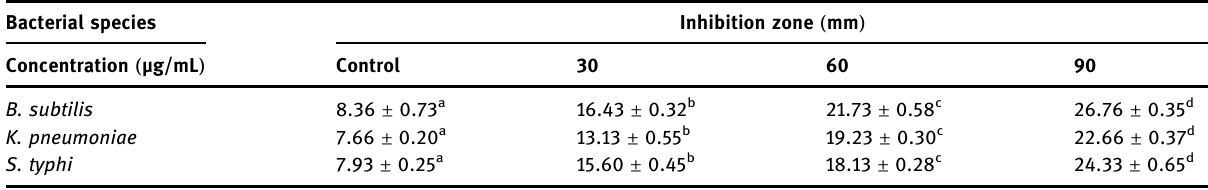
Table 5: Antibacterial activity of Cs - AgNPs on B. subtilis, K. pneumoniae , and S. typhi Bacterial species Concentration ( μ g/mL